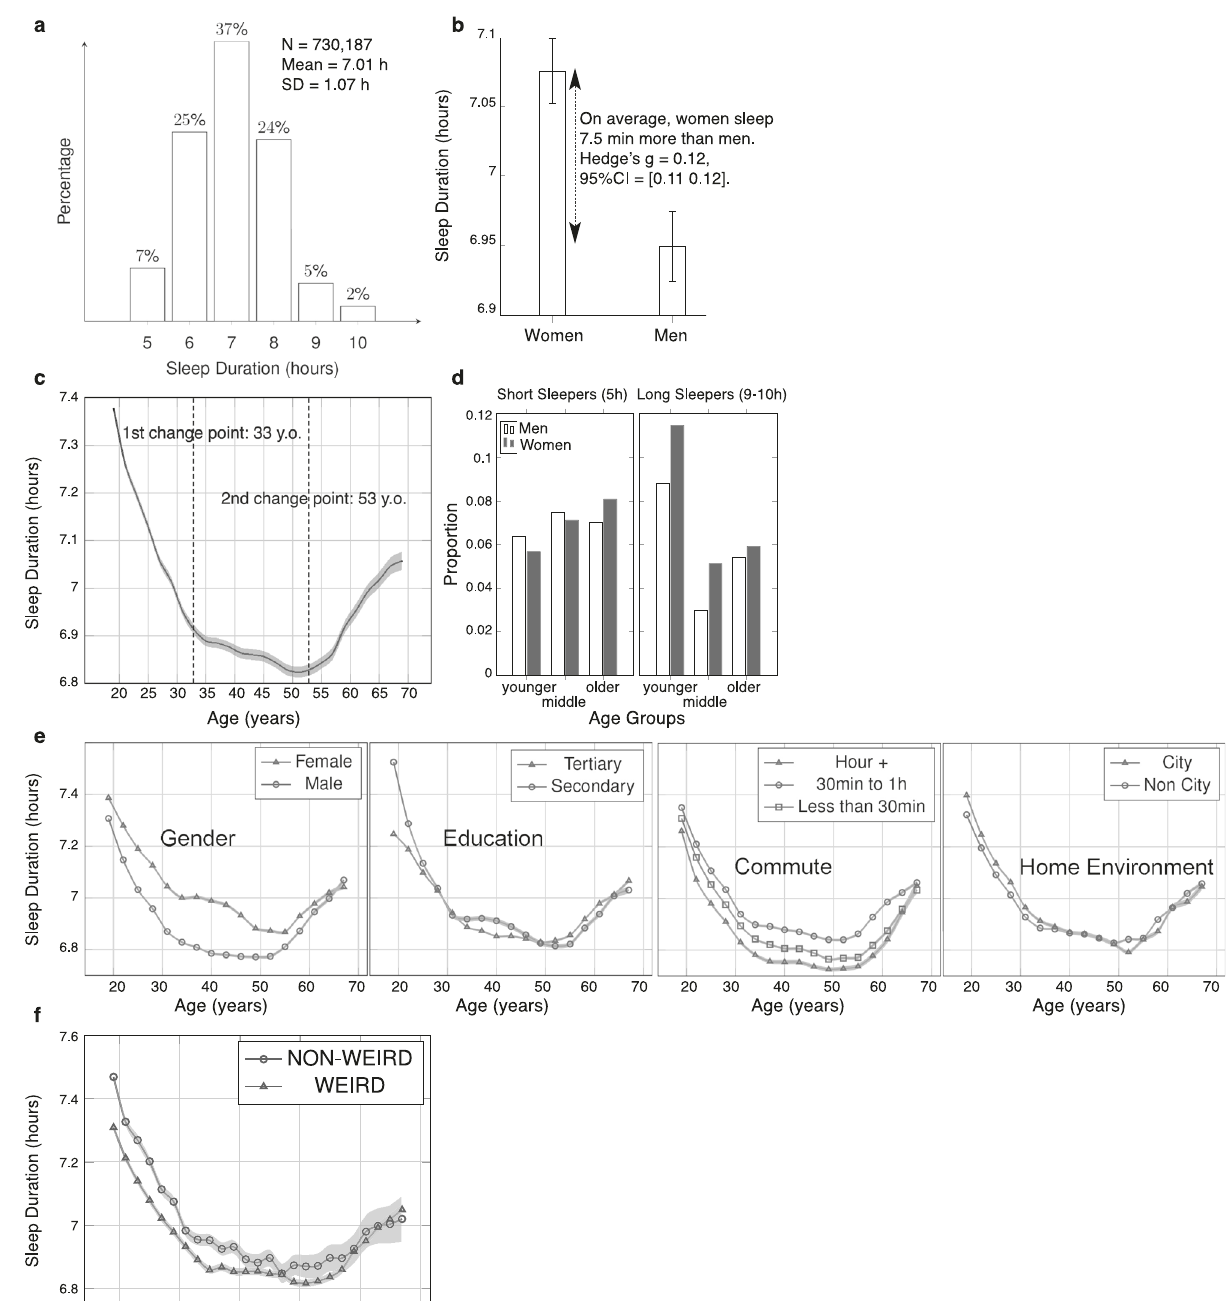
Fig. 1 | Distribution of reported sleep duration. a Distribution across 730,187 participantsover63countries( M =7.01h,SD=1.07h). b Reportedsleepdurationis shorter for men ( M =6.94h, SD=1.04h) than women ( M =7.07h, SD=1.09h). c Reported sleep durationacross the adultlifespan. This evolutioncan be split in 3 phases:asharpdecreasefrom19yearsto33years,aslowerdecreasefrom34years to53years,andare-increasefrom54yearsonwards. d Proportionofshort(5h)and long(9 – 10h)sleeperspergenderand agegroup. e Reportedsleep durationacross age for each gender (381,153 men, 349,034 women), level of education